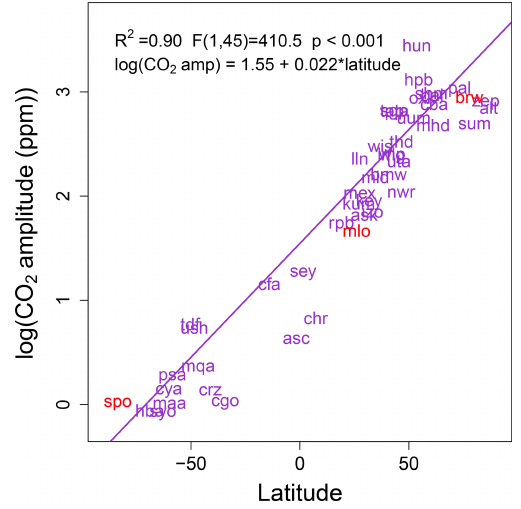
Figure 5. Latitudinal variation in the amplitude for detrended in situ surface CO 2 samples. Data are the average of peak–trough am- plitudes for 2005–2015, only including sites with a minimum of 5 years of data. Points are labeled according to the three-letter code of the sampling station. The South Pole (spo), Mauna Loa (mlo) and Barrow Island (brw) sites are highlighted in red for reference, as they are commonly referenced in literature. The latitudinal range in surface site CO 2 seasonal amplitudes ( ∼ 19ppm) is more than 2 times the latitudinal range in seasonal amplitudes of XCO 2